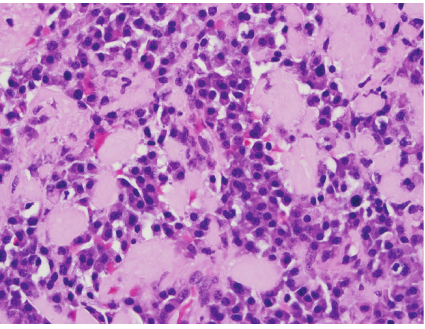
Figure 2: Photomicrograph shows infiltrate of mature plasma cells with associated amorphous eosinophilic amyloid deposits (hematoxylin and eosin stain, 600x